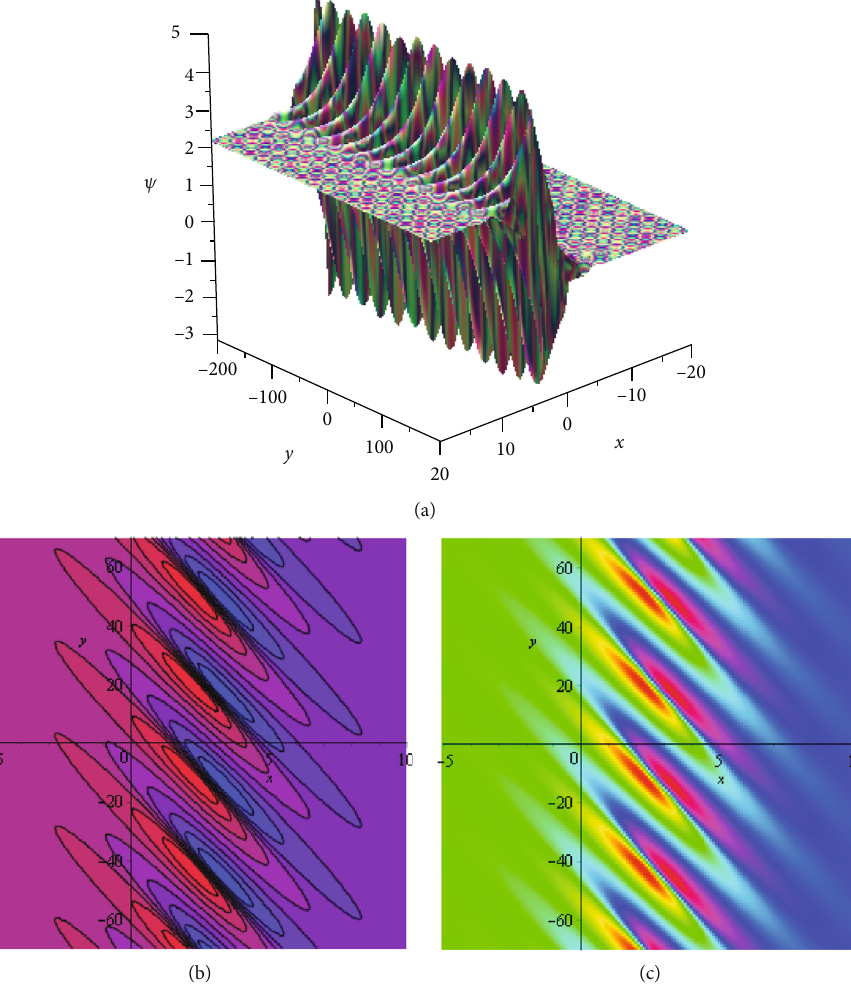
= : 5, a = 1 : 5, a = 2, a = 1, Ω = 1 : 9, Ω = : 2, Ω = 2, δ = 1, δ = 1 : 3, δ 1 2 3 4 4 5 7 1 2 3